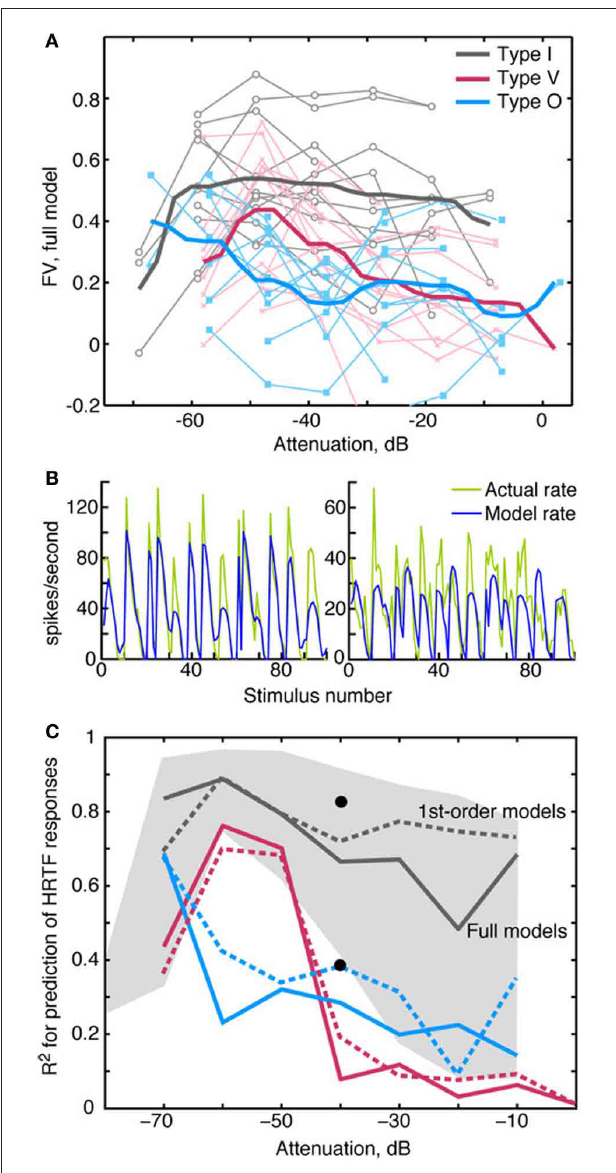
FIGURE 8 | Prediction quality for RSS and HRTF stimuli by sound level. (A) Quality of RSS response predictions ( fv ) plotted against the sound level of the stimulus. Light colored symbols connected by lines show data obtained from one neuron. Heavy colored lines show median fv -values for the 3 neuron types. For clarity in plotting, 1dB was added to the attenuations for V neurons, and 2dB was added to the attenuations for O neurons. (B) Predicted rate responses to HRTF-filtered noise (VS stimuli), computed using weight-function models derived at the same overall sound level ( − 40dB). Predictions for a type I (left) and a type O (right) neuron were computed using the difference method (see text). Actual rates are shown in green and predicted rates are shown in blue. The goodness of fit for these predictions are as follows: Type I (left): R 2 = 0 . 82, fv = 0 . 7; type O (right): R 2 = 0 . 39, fv = 0. (C) Median R 2 for the three neuron types. Solid lines indicate median R 2 -values obtained when the full model was used to predict responses to VS stimuli; dashed lines indicate median R 2 -values based only on 1st-order terms. The black dots show the positions of the two examples in (B) . The gray shaded region indicates the range of R 2 -values that were observed for type I neurons at each attenuation